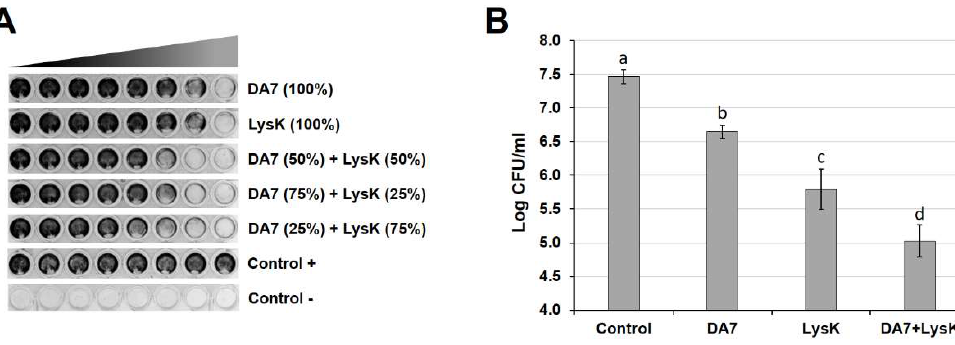
Figure 4. Synergistic effect of DA7 and LysK against S. aureus biofilms in static and dynamic models. ( A ) SA113 biofilms grown statically in 96-well plates were treated with two-fold serial dilutions of DA7, LysK, and mixtures of both enzymes at the ratios 50:50, 75:25, and 25:75, with the highest concentrations on the right and the lowest concentrations on the left of each row. After treatment, residual biofilms were stained with crystal violet. For each individual enzyme, the highest concentration used was the respective minimum biofilm eradication concentration (MBEC) and was defined as 100%. Highest concentrations of enzymes within mixtures are expressed as percentages of the respective MBECs. ( B ) Residual viable S. aureus on the glass surface of the Biostream flow cell after a 2 h treatment of dynamic biofilms with buffer (control), DA7 (0.625 nM), LysK (1.25 µ M), or a combination of both (0.156 nM DA7 + 0.938 µ M LysK, corresponding to a ratio of 25:75). Error bars represent standard deviations from at least seven independent experiments. Bars with different letters are significantly different from each other ( p < 0.05).